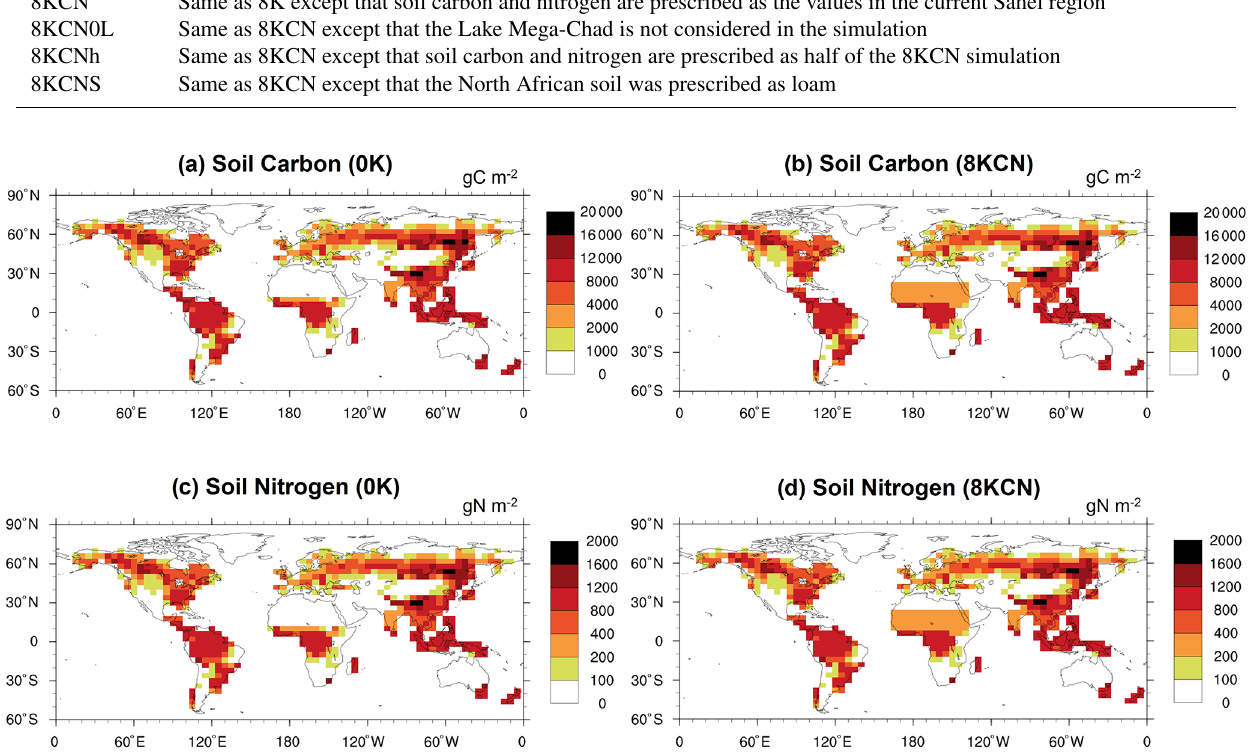
Figure 1. Global maps of soil carbon (a, b) and nitrogen (c, d) used in the 0K and 8KCN